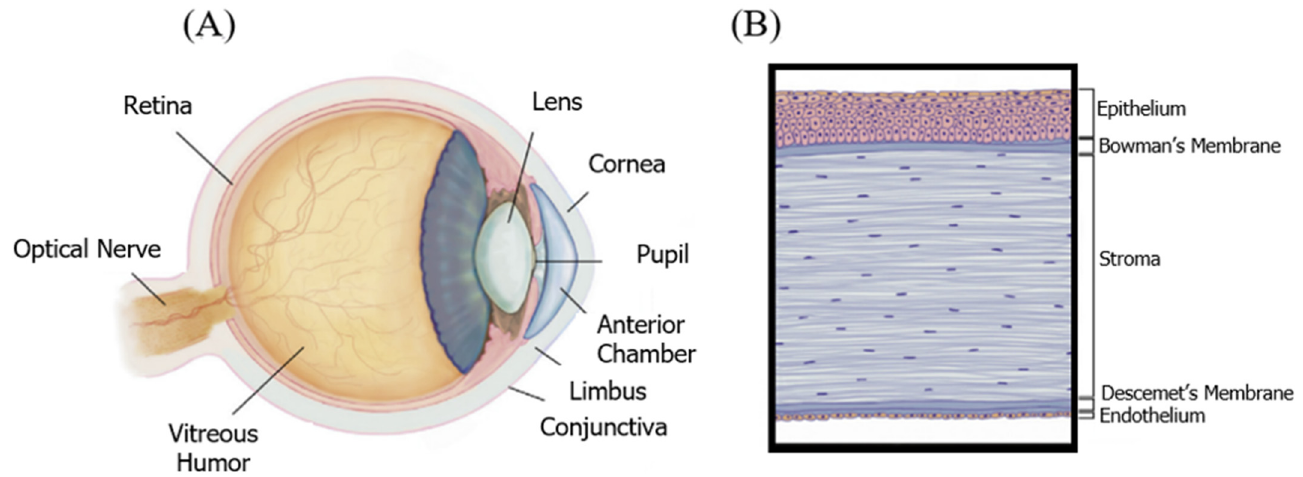
Figure 1. ( A ) The anatomy of the eye, cornea. ( B ) The cornea is an optically transparent multilayered structure consisting of three cell layers and two membranes. Adopted and modified from [1] (Chapter 67) with permission.